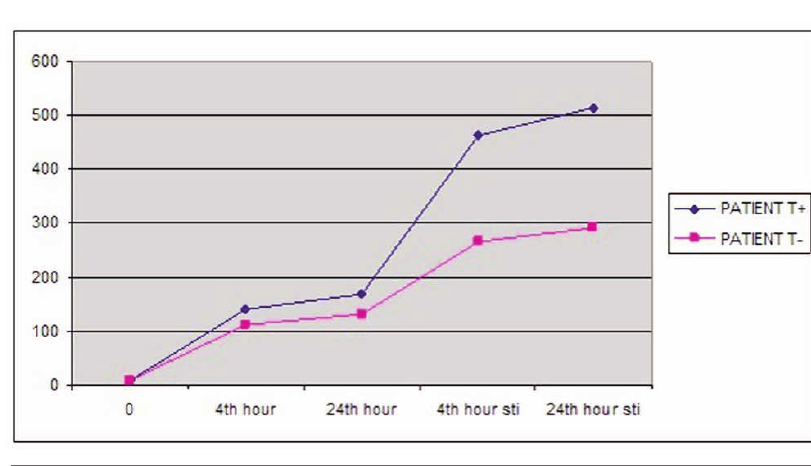
Figure 2. Spontaneous and stimulated levels of IL-1 β in patients who carry and who do not carry T allele (pg/mL). Sti, stimulated; T+, patients who carry T allele; T-, patients who do not carry